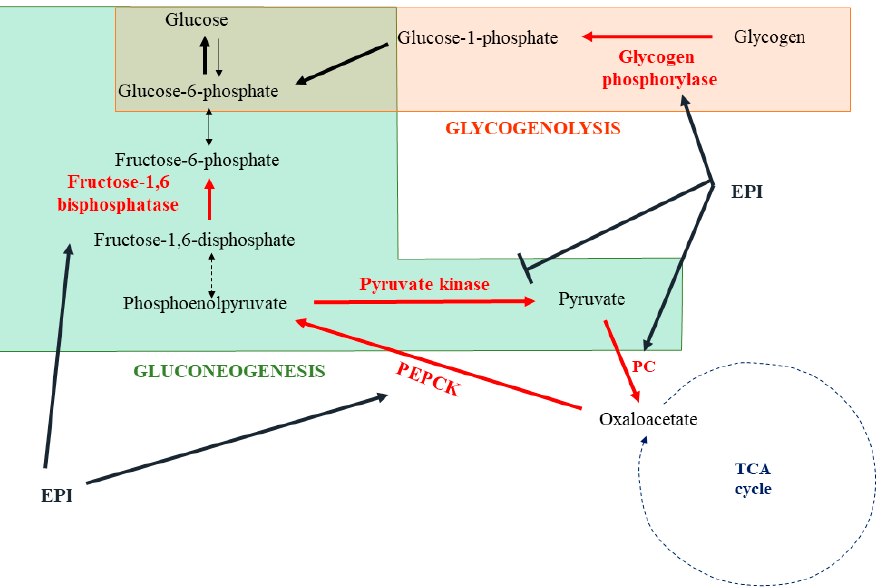
Figure 4. Impact of epinephrine on hepatic gluconeogenesis and glycogenolysis. Epinephrine (EPI) activates or inhibits some metabolic enzymes involved in glycogenolysis and gluconeogenesis ( → ac- tivation; —| inhibition). EPI: epinephrine; PC: pyruvate carboxylase; PEPCK: phosphoenolpyruvate carboxykinase; TCA cycle: tricarboxylic acid